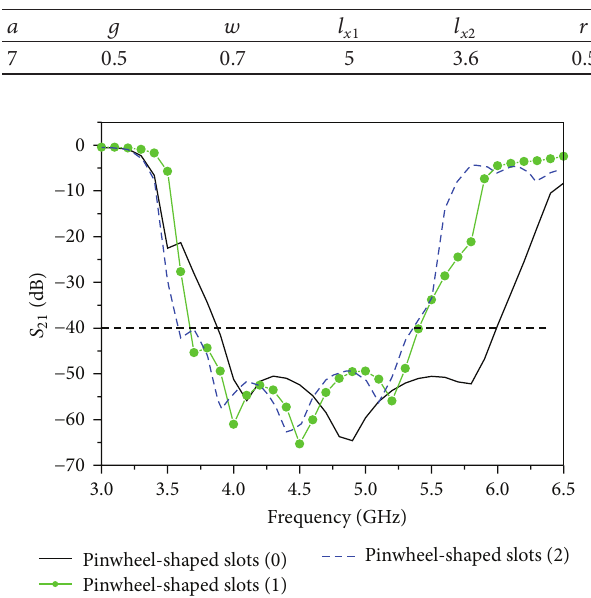
Figure 8: Simulated 𝑆 21 as various numbers of pinwheel-shaped slots.